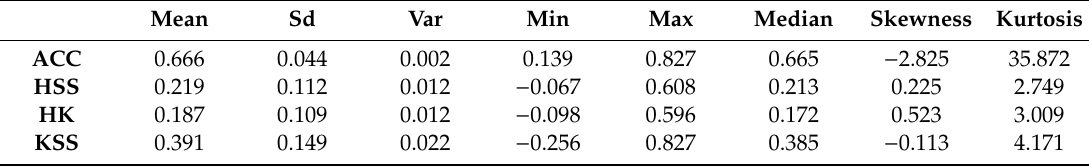
Table 7. Statistics for the scores of the Artificial Neural Network (ANN) method (test data set).